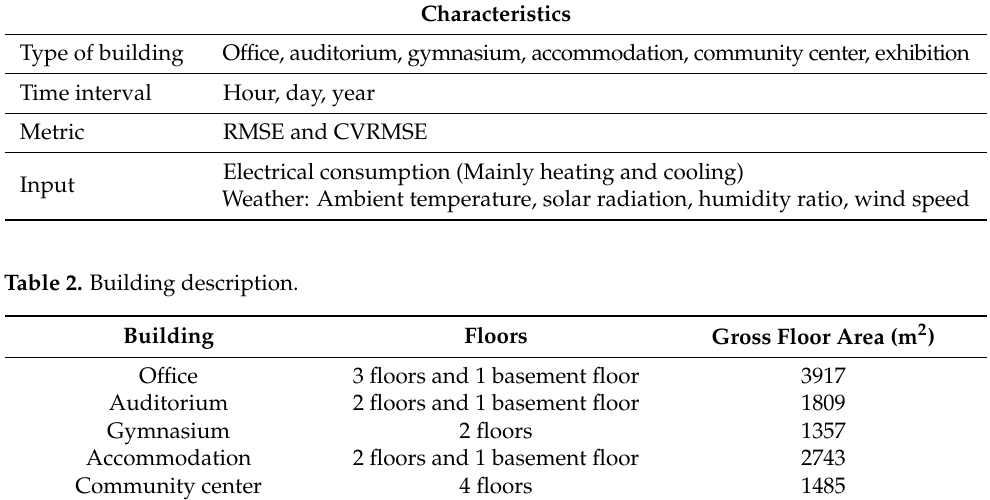
Table 1. Summary of the KNN algorithm.